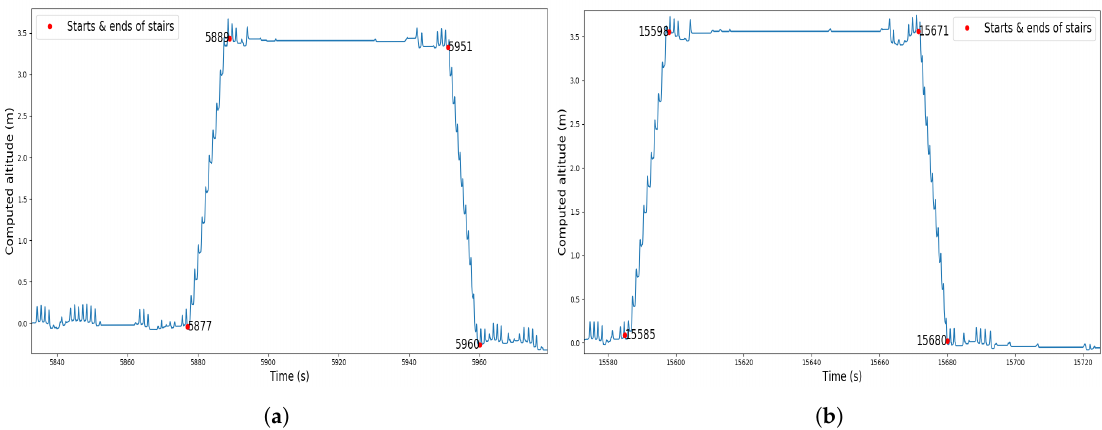
Figure 8. Computed altitude during ( a ) the first walking period and ( b ) the third walking